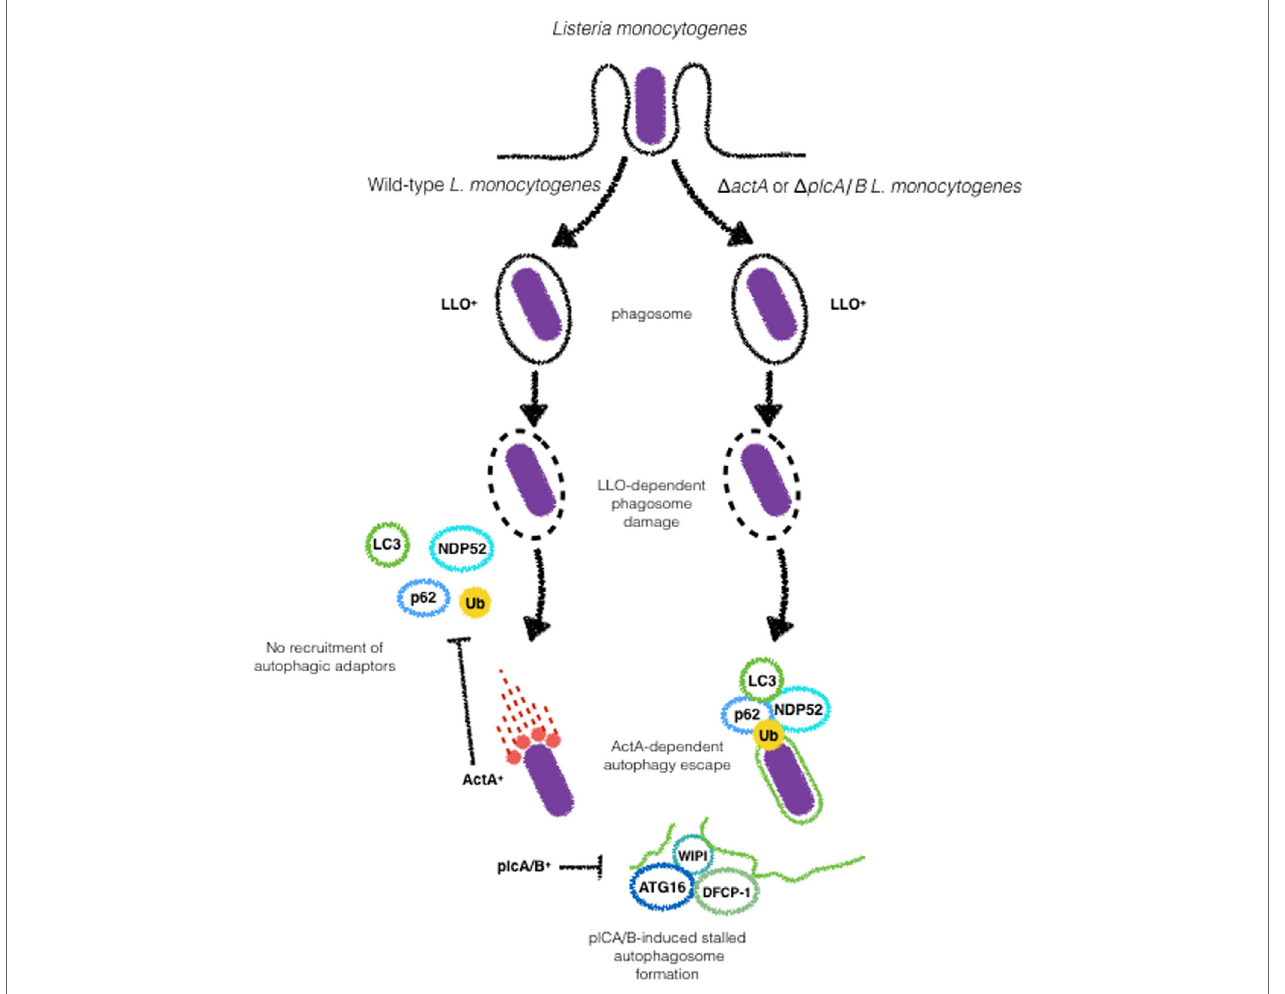
FigURe 5 | ActA and phospholipases (plc) A and B are major Listeria monocytogenes virulence factors involved in the escape from autophagy. Upon Listeriolysin O-dependent escape from phagosome wild-type L. monocytogenes escapes from autophagic targeting due to the expression of ActA, that blocks the recruitment of p62 and NDP52 to the bacterial surface. The expression of plcA/B stalls the formation of autophagosomal membranes. Galectin recognition of damaged vacuoles and autophagy induction are not shown